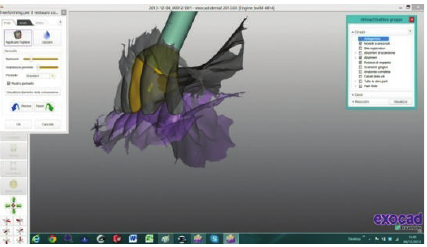
Figure 12: The temporary crown was digitally drawn before sending to the 3D printer.